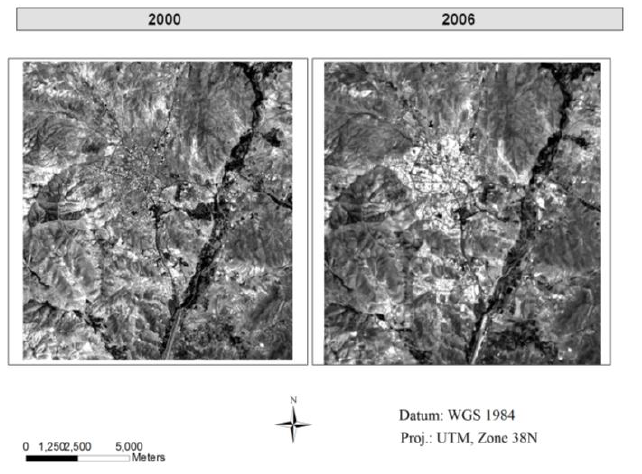
Figure 1 Sanandaj satellite imageries